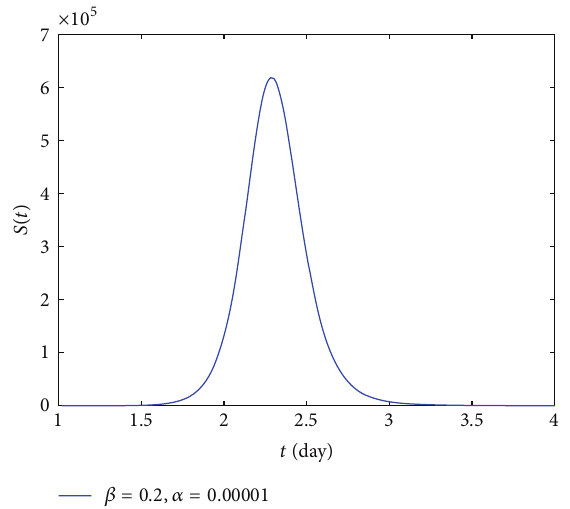
Figure 4: The number of each subclass in terms of time under different conditions, where 𝐼(0) = 5000000 , 𝑆(0) = 10 , 𝑅(0) = 0 , 𝑊(0) = 0 , 𝛽 = 0.2 , 𝛼 = 0.00001 , 𝑑𝐼/𝑑𝑡 = −0.000602 , and 𝑑𝑊/𝑑𝑡 = 50